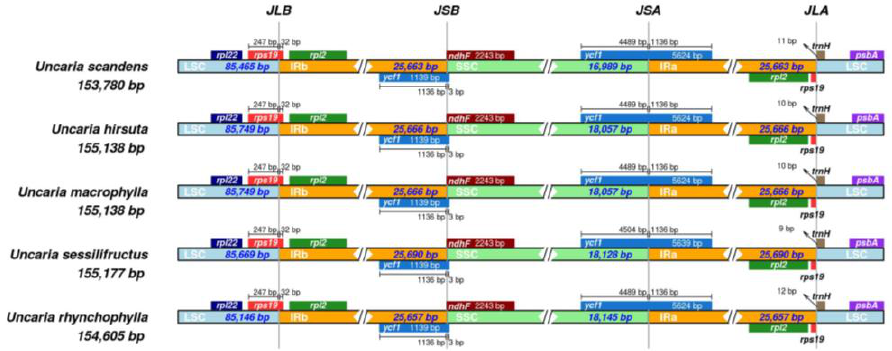
Figure 8. Comparison of LSC, IR, and SSC junction positions among five Uncaria species in cp genomes. JLB denotes the LSC/IRb junction, JSB denotes the SSC/IRb junction, JSA denotes the SSC/IRa junction, and JLA denotes the LSC/IRa junction.